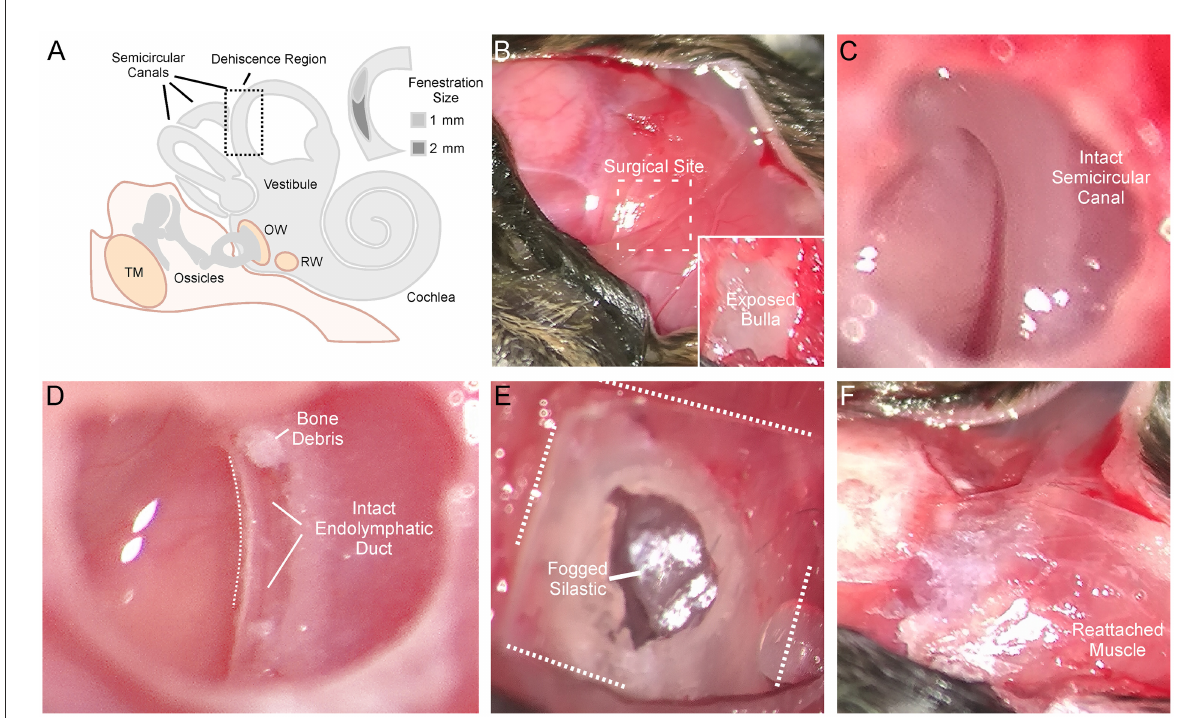
FIGURE1 Detailed surgical method for creating left semicircular canal dehiscence (SSCD). (A) Cartoon showing the middle/inner ear and the location of the surgically created SSCD “third mobile window.” The inset shows the dehiscence site. (B) Photomicrograph showing the exposed skull (top left). The exposed nuchal muscles can be seen (center and bottom right). In the inset, after the muscles are taken down from the bulla, the superior bulla is exposed. (C) The superior bulla is opened widely with a 1.5-mm diamond bur and the dissection is carried near, but not into the surrounding sinus, to avoid bleeding. Through the open bulla, the intact superior semicircular canal can be seen. (D) Using a 1-mm diamond bur, a controlled fenestration of the superior (anterior) semicircular canal is completed. It should be noted that the bone of the superior semicircular canal, including the endosteum, is precisely removed. The endolymphatic duct can be seen to be intact illustrating the precise surgical creation of the SSCD. Sterile physiologic saline is used to irrigate away bone debris. Note, bone debris at the margins of the fenestration cannot be removed by irrigation. This no doubt contributes to bone regrowth. The perilymph is open/exposed just as patients with SSCD have their perilymph exposed. (E) Photomicrograph shows the sealing of the bulla with Silastic to partition the air-filled bulla from the overlying neck muscles thereby restoring the normally air-filled middle ear. Note condensation on the interior surface of the Silastic seal. (F) The reattached muscles are glued to the skull with Medbond. This allows c + VEMP testing beginning the day after the surgical creation of the